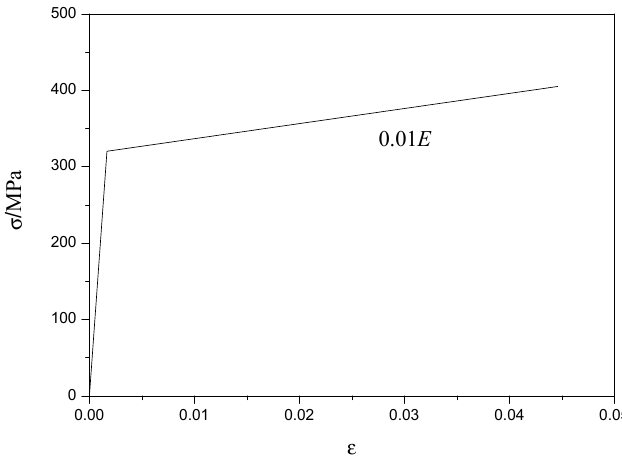
Figure 17. Stress–strain relationship of profiled steel sheeting.